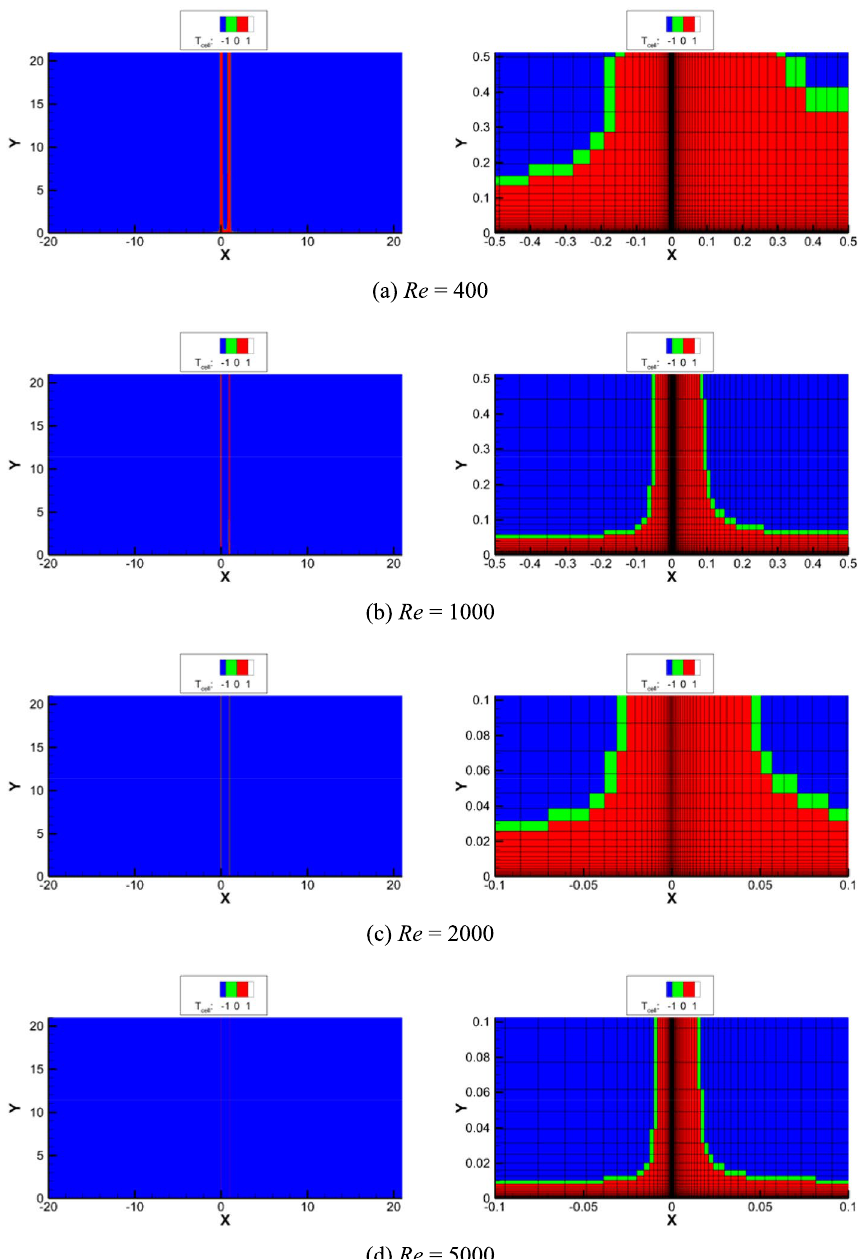
Fig. 12 Distribution of the DUGKS cell and the N-S cell for flow around a flat plate with different Reynolds numbers in the continuum flow regime (Left: global view; Right: local